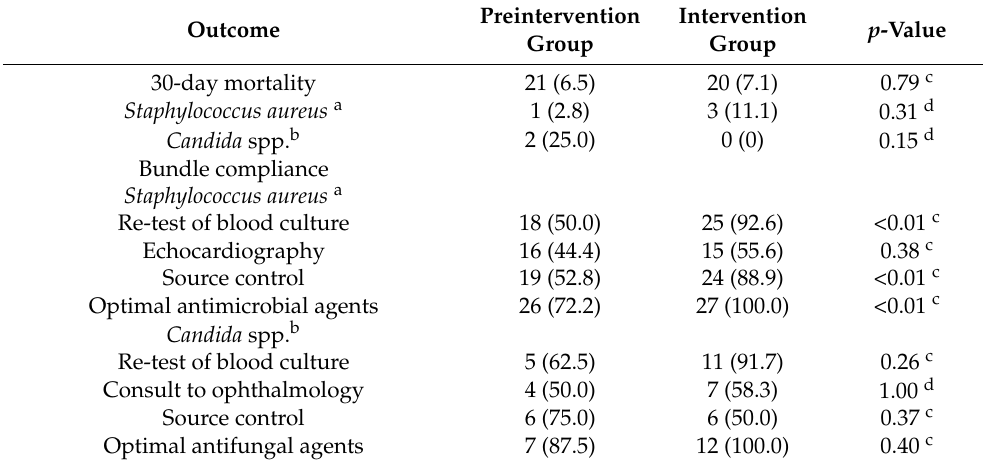
Table 4. Secondary outcome